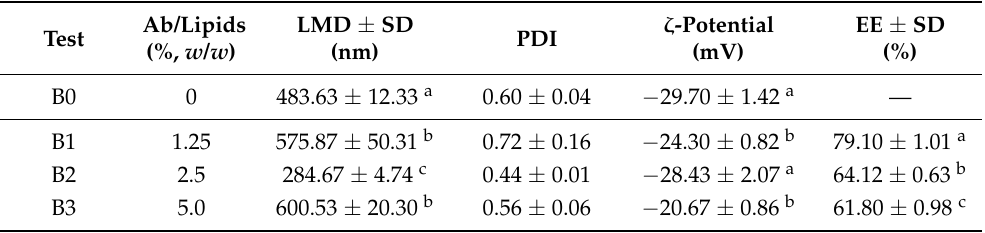
0.56 ± 0.06 − 20.67 ± 0.86 b 61.80 ± 0.98 c